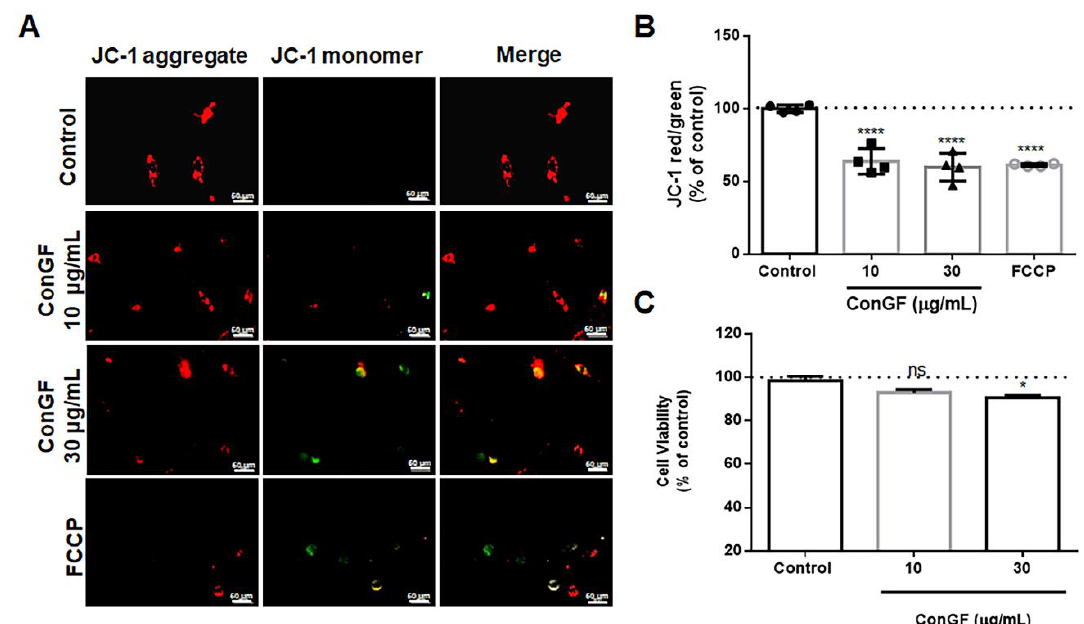
Figure 4. ConGF alters mitochondrial membrane potential. C6 glioma cells were incubated with vehicle (control) or ConGF (10 or 30 µ g/mL) for 3 h. Carbonyl cyanide p-trifluoromethoxy phenylhy- drazone (FCCP), a mitochondrial uncoupler, was used as positive control to fluorescence emission. ( A ) Illustrative images from cells stained with JC-1. ( B ) shows mitochondrial potential evaluated by JC-1 after 3 h of treatment. ( C ) shows cell viability measured by the MTT assay after ConGF treatment for 3 h. The data are expressed as a percentage of control, and the values are presented as mean ± SEM of four independent experiments performed in triplicate. * p < 0.05, **** p < 0.0001, as compared to control. ns = no significative.